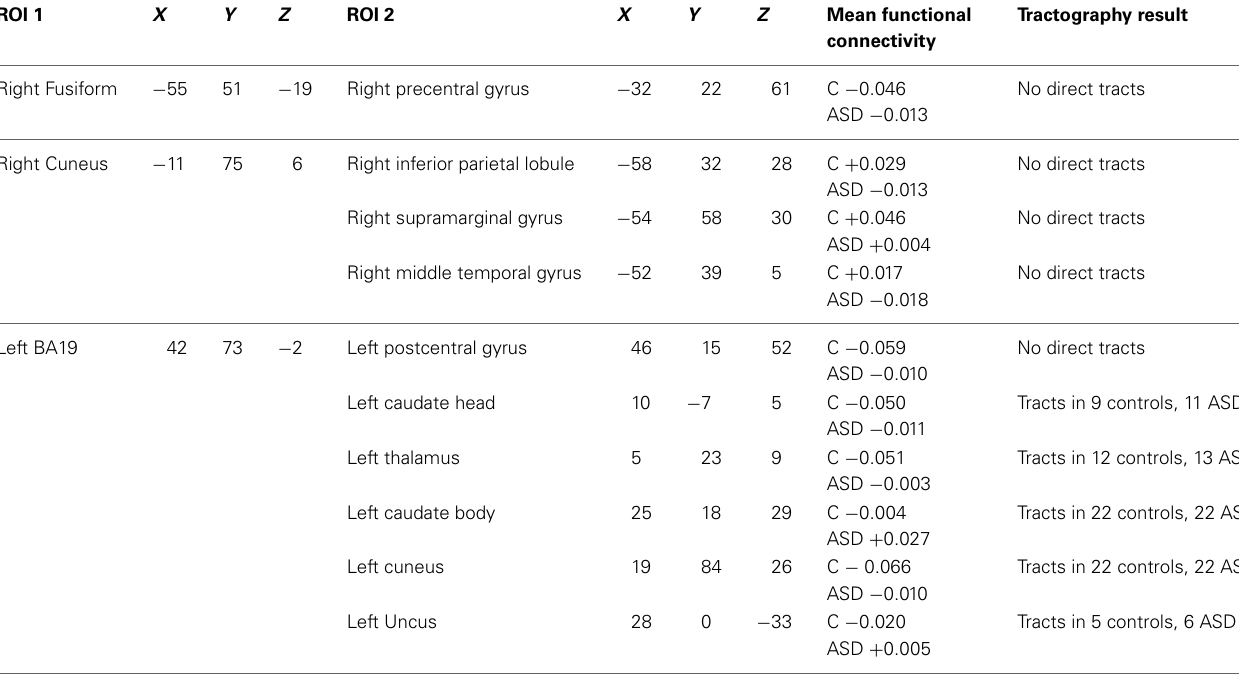
Table 3 | Summary of results from functional connectivity and tractography analysis. ROI